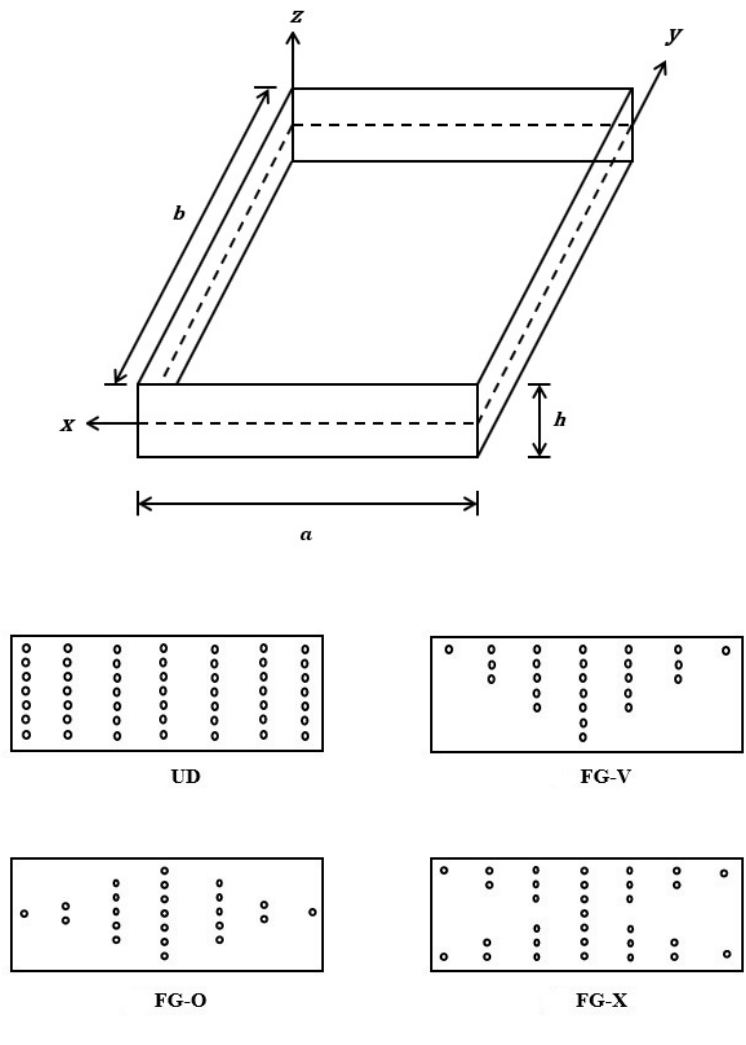
Figure 1. The geometry and configuration of carbon nanotube reinforced plate.